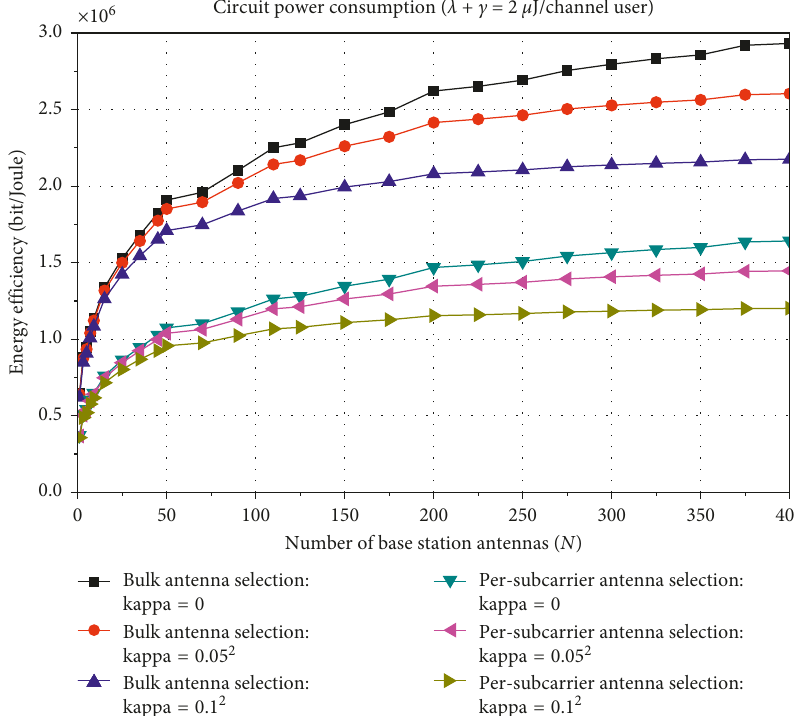
Figure 2: Energy efficiency of the massive MIMO-OFDM channel versus the number of BSA for per-subcarrier selection and bulk antenna selection techniques using various hardware impairments (kappa